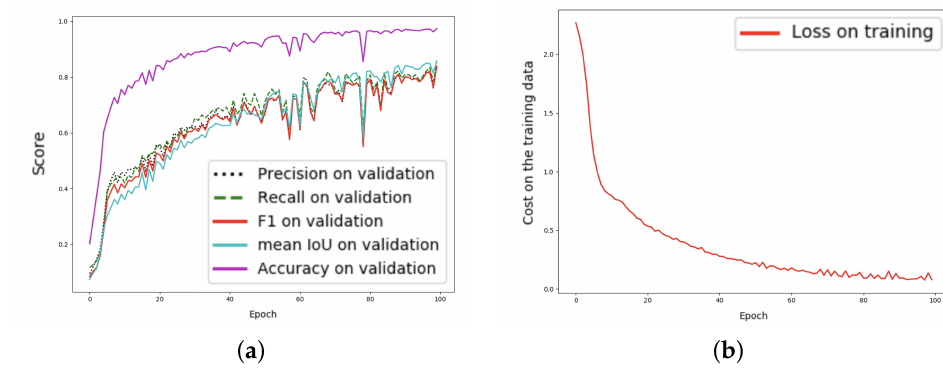
Figure 7. Graph (learning curves) of the Road Asset corpus of the baseline approach, “YOLOv5L”; x refers to epochs, and y refers to different measures ( a ) Plot of model loss (cross-entropy) on training and validation corpora; ( b ) performance plot on the validation corpus.